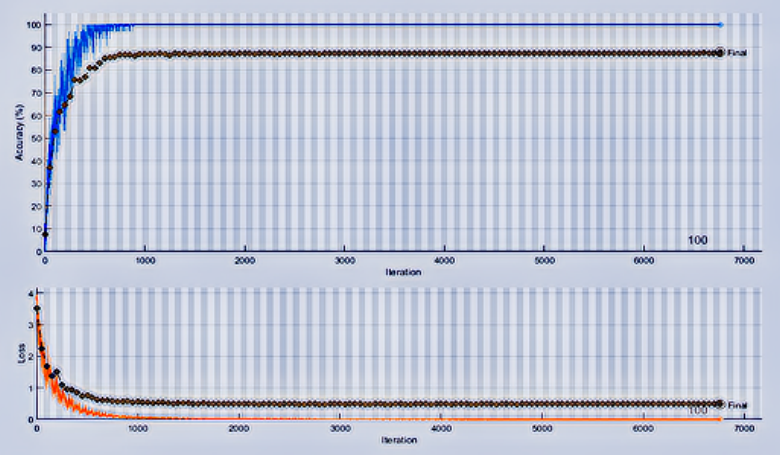
Figure 4. CNN training